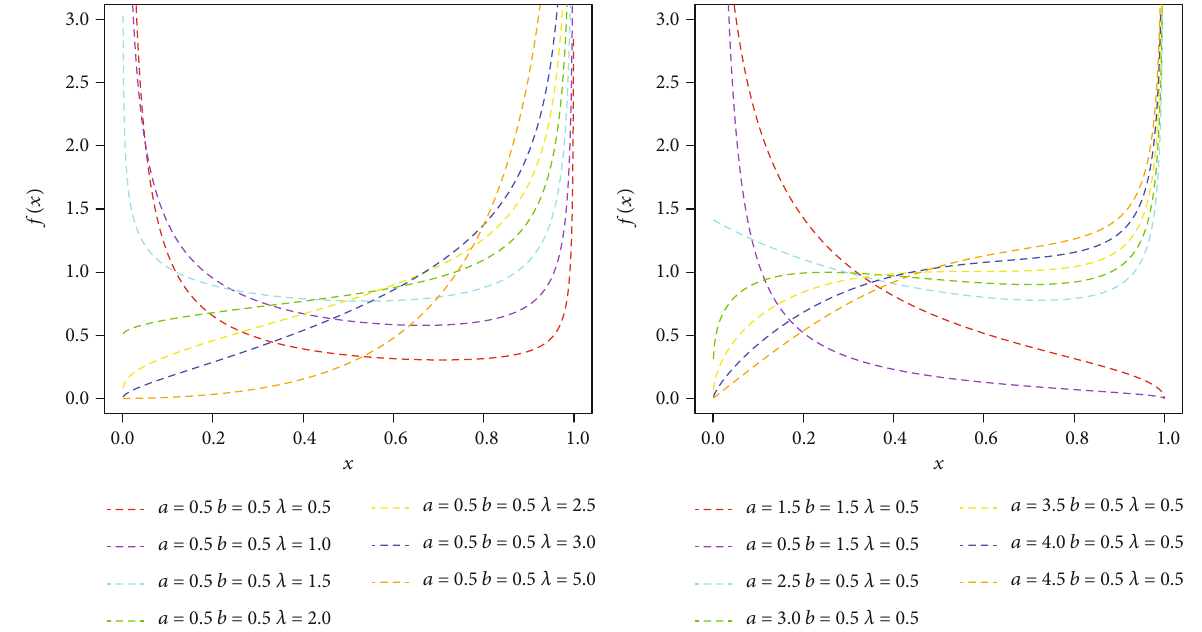
Figure 1: Pdf plot of TIIHLKwD.